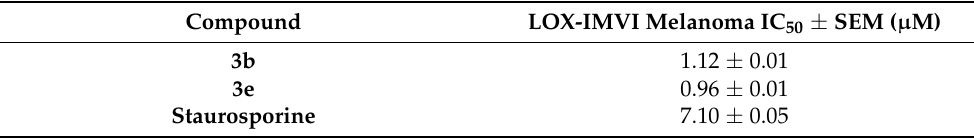
Table 3. IC 50 of compounds 3b and 3e against LOXIMVI melanoma cell